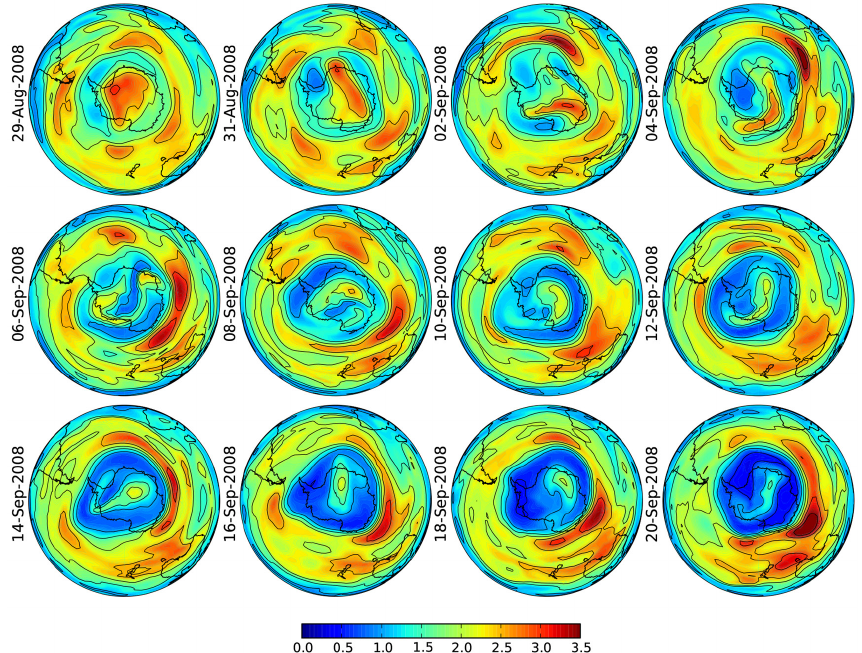
Figure 8. Ozone distributions at 54.6hPa (model level 22) for the Antarctic region. The snapshots are taken for the period between 29 August and 20 September every two days. Contours are plotted for every